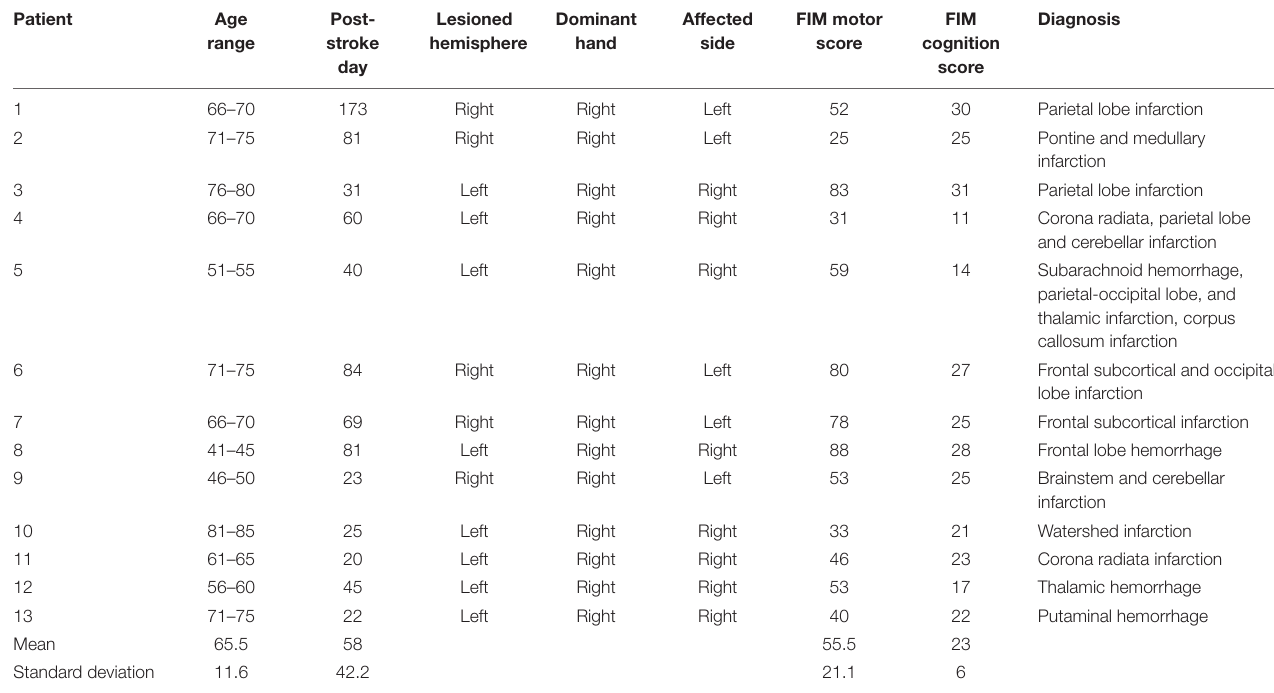
TABLE 2 | Description of the participants in the without construction apraxia